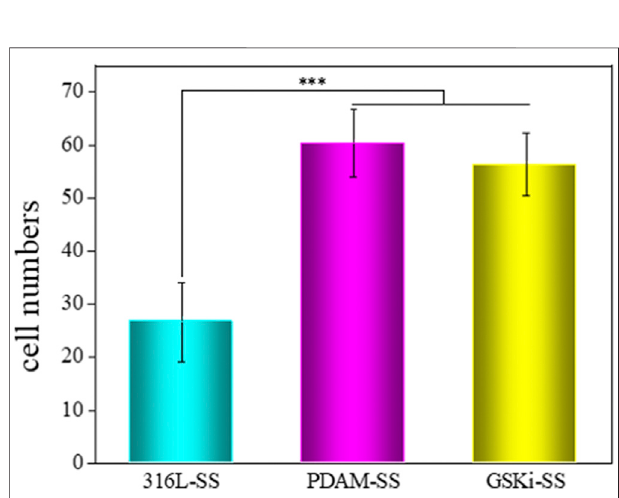
FIGURE 7 | Cell adhesion numbers on various samples after 2 h of incubation (mean ± SD, *** p <